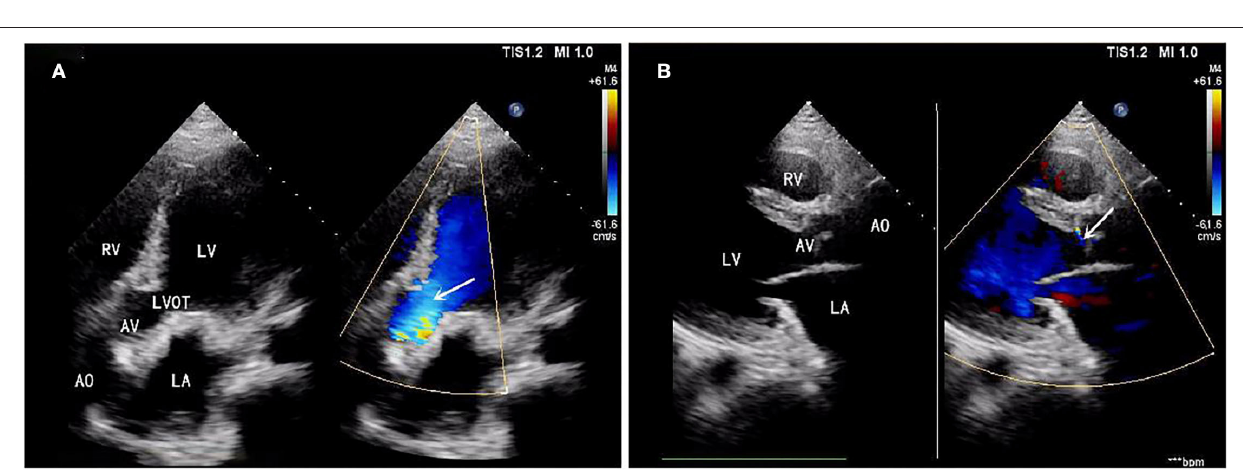
FIGURE 5 | (A) Left ventricular outflow tract obstruction disappeared (Gradients of LVOT 7 mmHg). (B) Trivial aortic